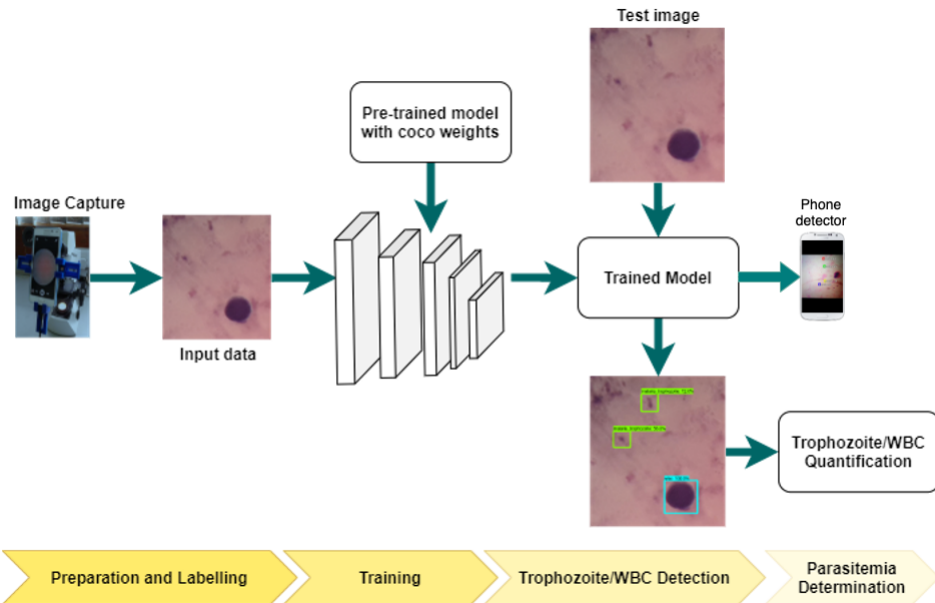
Figure 2. Pipeline for our automated mobile-aware localization of malaria trophozoites and White Blood Cells